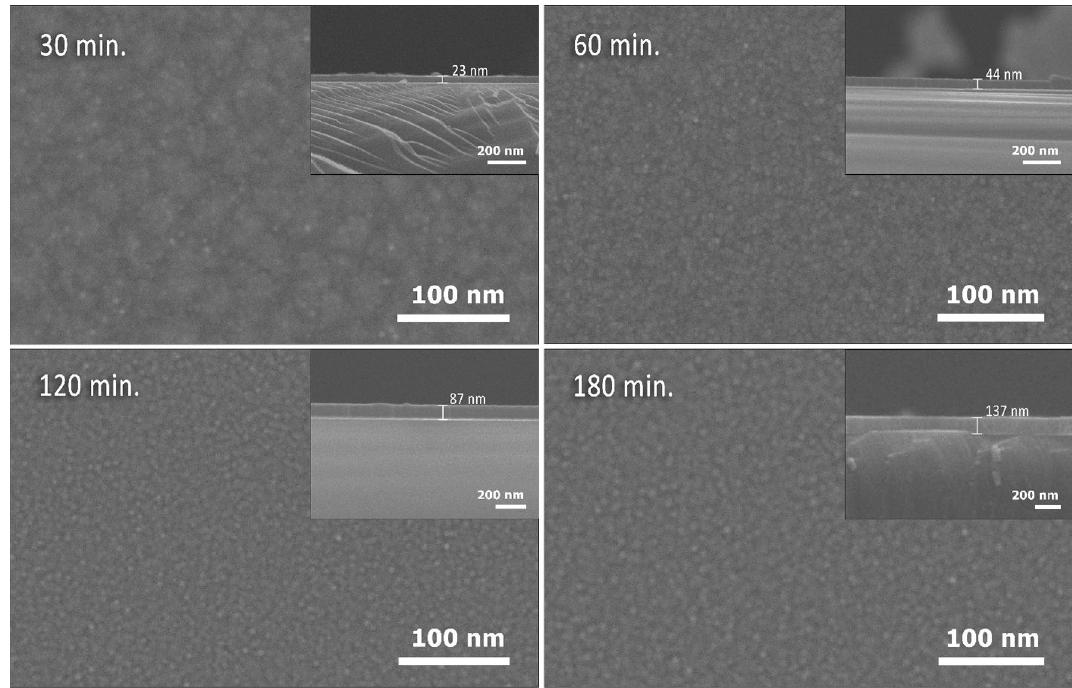
Figure 2. A typical FESEM images showing the morphology and fractured cross-section (as an inset) of carbon nitride films prepared at deposition time of 30, 60, 120, and 180